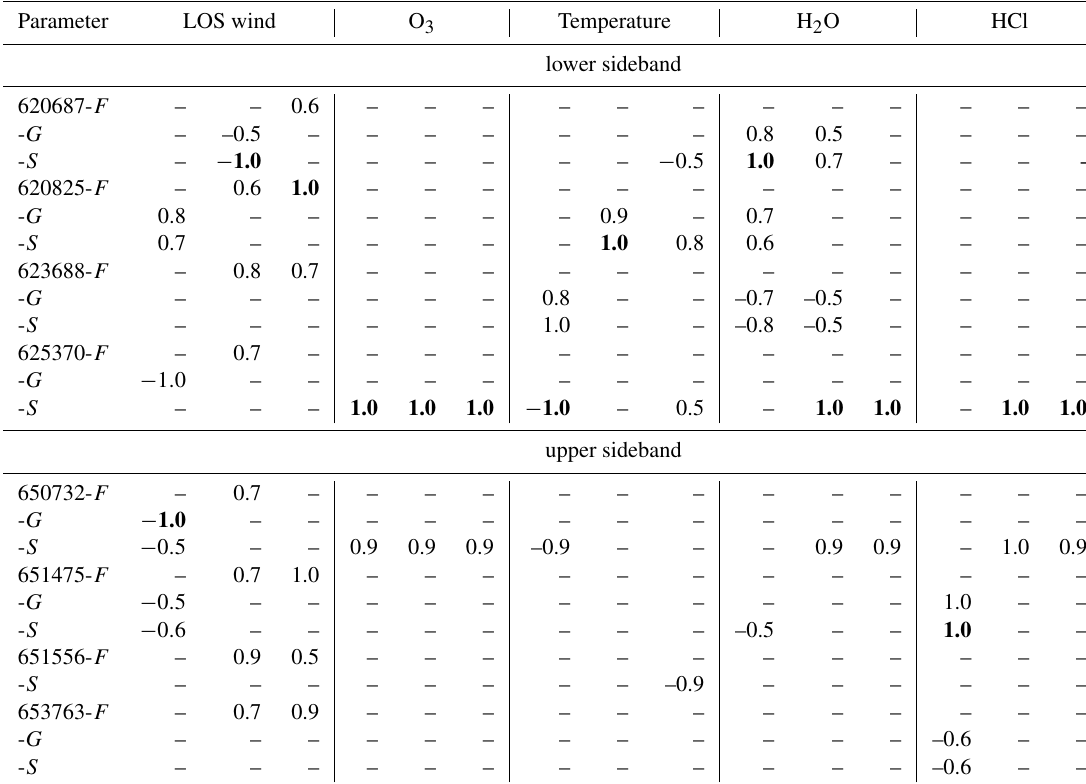
Table A1. Relative impact of O 3 line parameters on temperature, O 3 , H 2 O and LOS wind retrievals. For a retrieved product, the impact is defined as the ratio of the error to the maximum error (see text). Results are given for 10, 1 and 0.1hPa levels (equatorial nighttime conditions). Only parameters having an impact larger than 0.5 at any of the considered altitudes are shown. The parameters are the center frequency ( S ), the air-broadening parameter ( G ) and the line strength ( S ). The line is characterized by its frequency